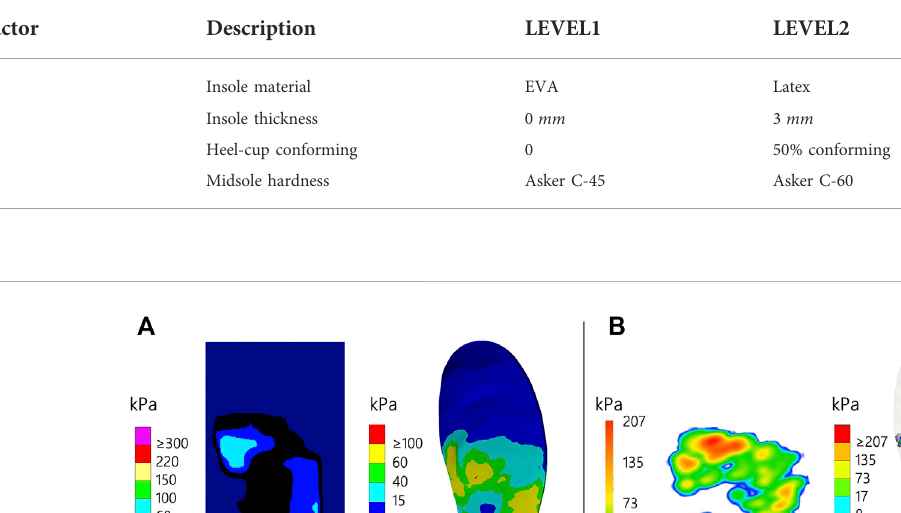
TABLE 2 Description of design factors and levels related to the Taguchi Method.